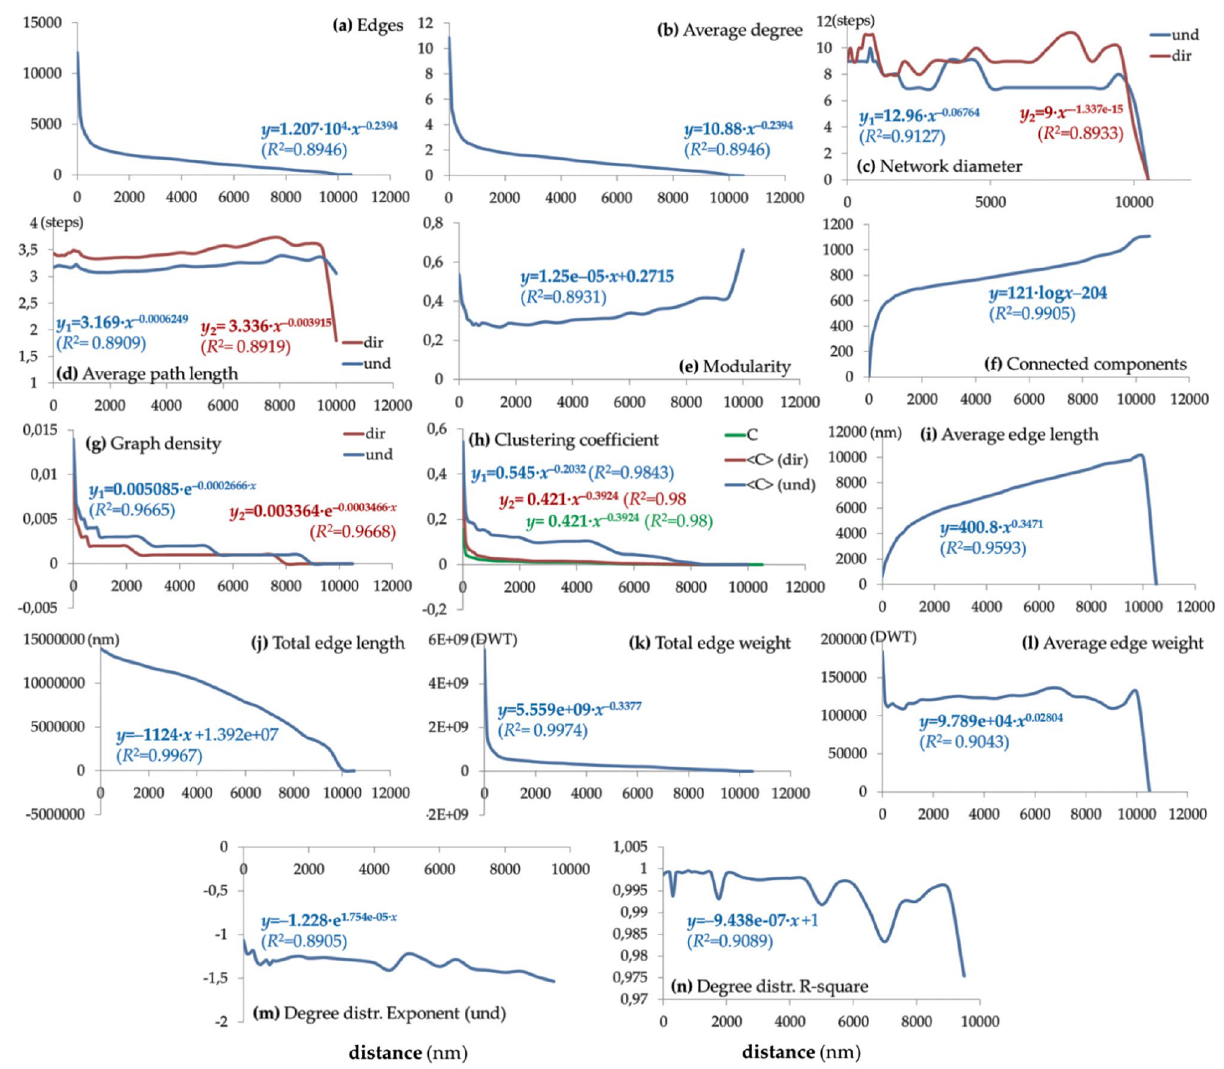
Figure 5. Line plots (metric scale) showing the distribution of major network measures of ( a ) network edges, ( b ) average degree (und), ( c ) network diameter (dir/und, measured in steps), ( d ) average path length (dir/ und, measured in steps), ( e ) modularity, ( f ) number of connected components, ( g ) graph density (dir/und), ( h ) clustering and average clustering coefficient (dir/und), ( i ) average edge length (nm), ( j ) total edge length (nm), ( k ) total edge weight (DWT), (l) average edge weight (DWT), ( m ) PL degree distribution exponent (und), and ( n ) PL degree distribution determination (R 2 ), which are expressed as a function of distance and computed on the series of layers composing the multilayer model of GCSN (as shown in Fig. 1). Equations of the best possible (those with max R 2 ) fitting curves are shown per